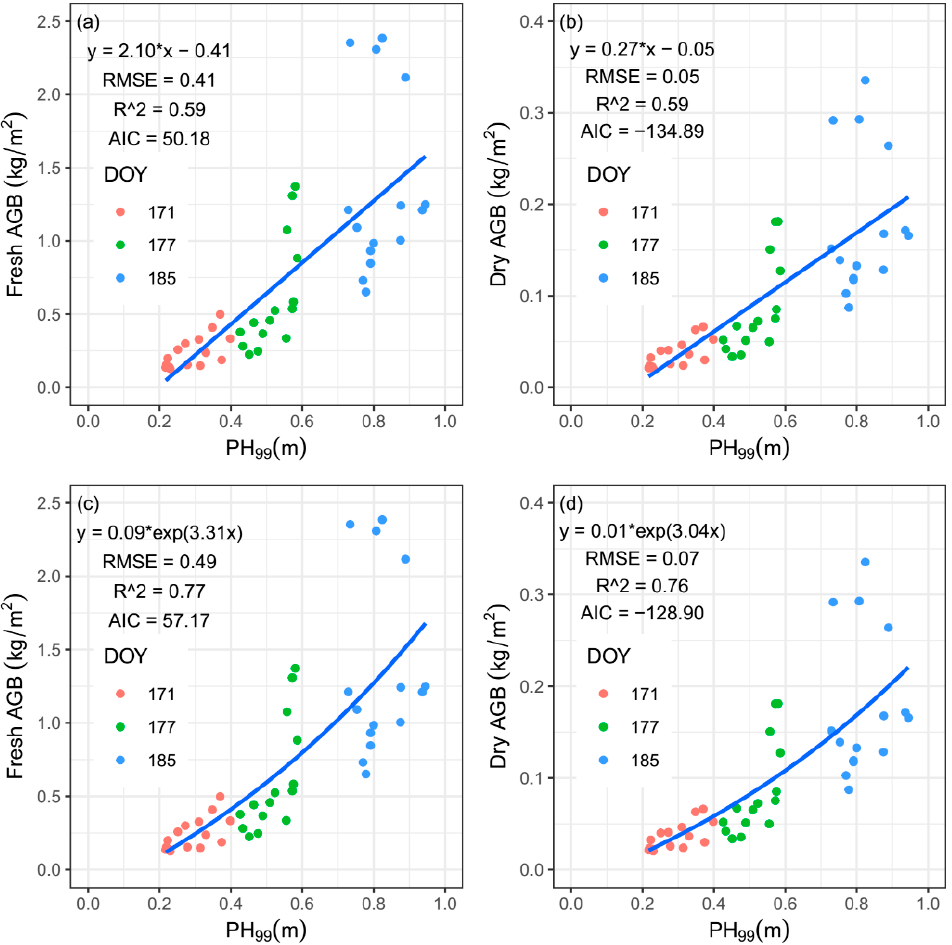
Figure 7. Correlations between maize plant heights derived from UAV RGB point clouds and ground-truth fresh or dry above-ground biomass (AGB). Maize plant height (PH 99 ) observations were obtained by using the 99th percentile of point clouds altitude to represent the plant level. AIC represents the Akaike Information Criterion; ( a , c ) were the linear and exponential regression models for fresh above-ground biomass, respectively; ( b , d ) were the linear and exponential regression models for dry above-ground biomass, respectively.